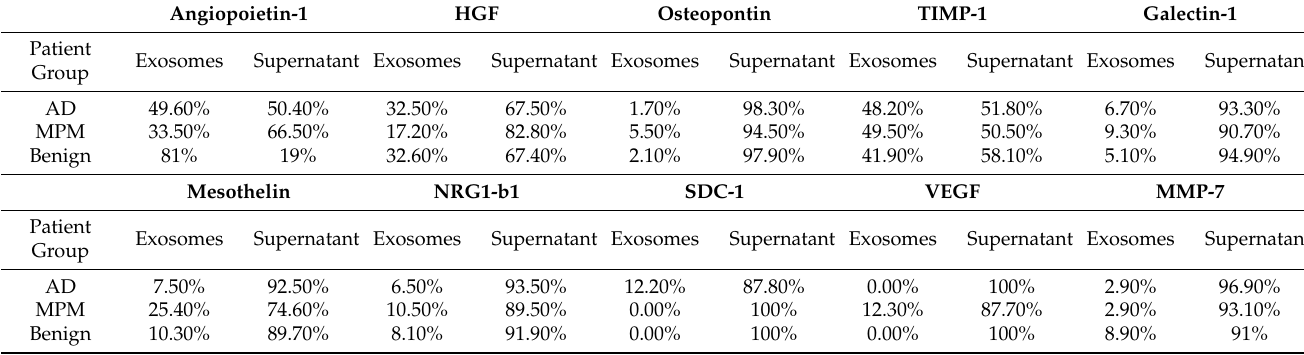
Table 1. Comparison of protein concentration in exosomes and supernatant of specific diseases.